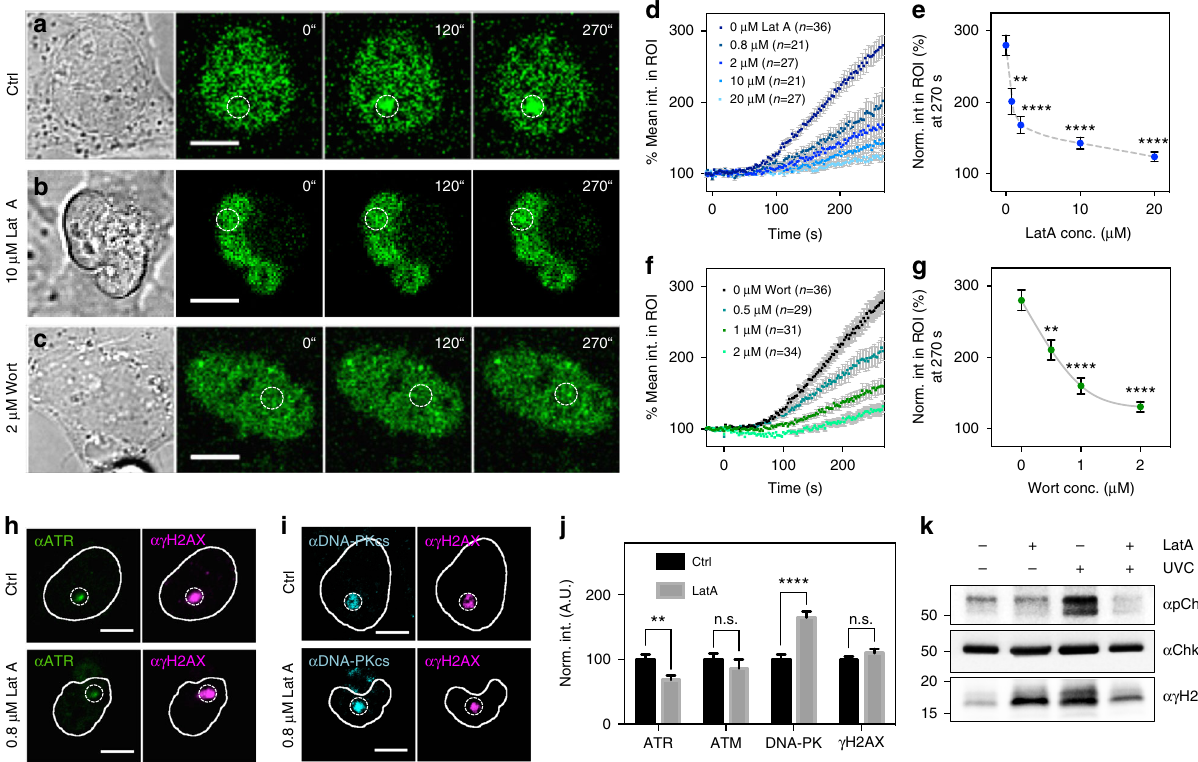
Fig. 5 Recruitment of ATR but not ATM or DNA-PKcs depends on fi lamentous actin assembly. Confocal montage together with the bright fi eld images of cells stably expressing GFP-ATR showing the recruitment of ATR to damage sites a control conditions, b 10 μ M Lat A and c 2 μ M wortmannin. d GFP-ATR recruitment at damage sites was suppressed by Lat A in a dose-dependent manner. e Corresponding quanti fi cation of accumulation magnitude of GFP-ATR at 270 s after microirradiation dropped with increasing Lat A concentration from 0.8 to 20 μ M. f The recruitment of GFP-ATR was also inhibited by wortmannin in a dose-dependent manner. g Corresponding accumulation magnitude of GFP-ATR at 270 s after microirradiation dropped with increasing wortmannin concentration from 0.5 to 2 μ M. Representative immuno fl uorescent micrographs stained for h ATR/ γ H2AX and i DNA-PKcs/ γ H2AX after microirradiation in the presence or absence of 0.8 μ M Lat A. j Corresponding normalized quanti fi cation of panel h&i and the staining for ATM (image not shown) ( n = 13 for ATR; n = 15 for both ATM and DNA-PK; n = 43 for γ H2AX staining). k Pre-treatment of Lat A at 10 μ M for 30 min signi fi cantly suppressed the activation of Chk1 by ATR upon global UV irradiation. Error bars represent mean ± s.e.m. in all panels. Dashed circles indicate the ROI for laser microirradiation. Scale bars are 10 μ m for all panels. Data are representative of three independent experiments. Student ’ s t -test, ** p < 0.01; *** p < 0.001; **** p < 0.0001. n.s. represents not signi fi